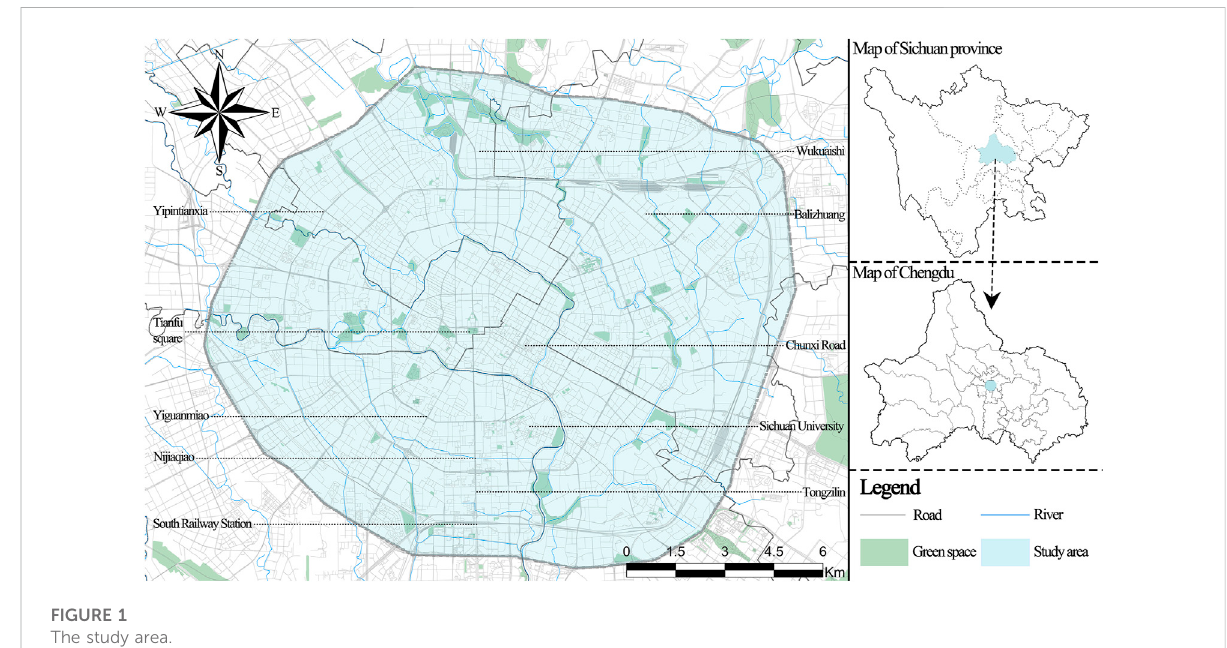
FIGURE 1 The study